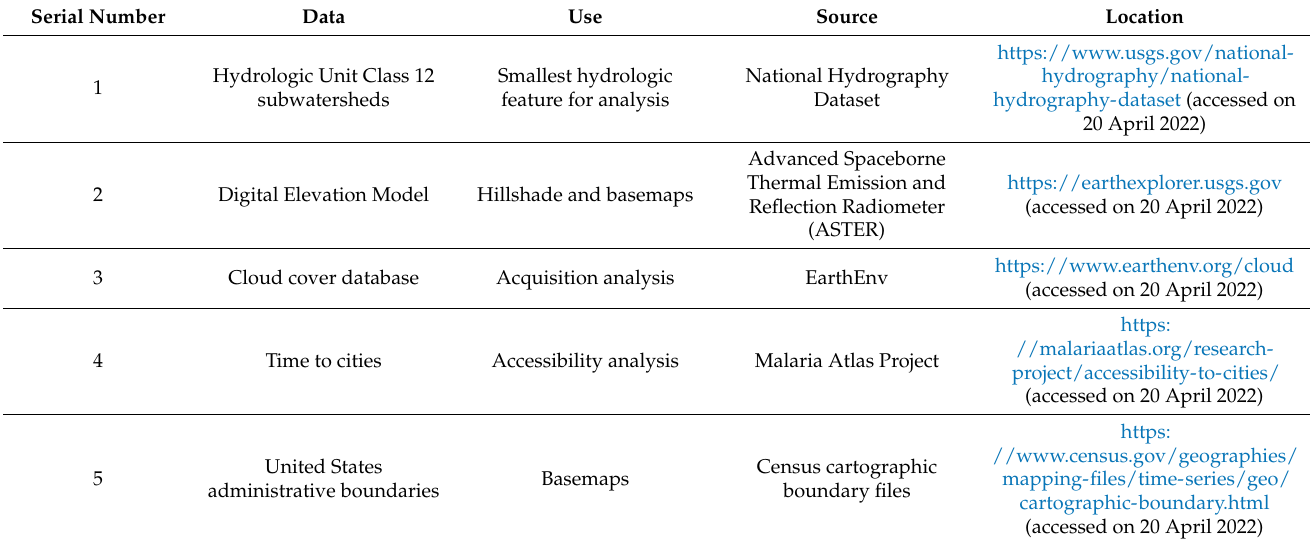
Table 1. Data sources used in this